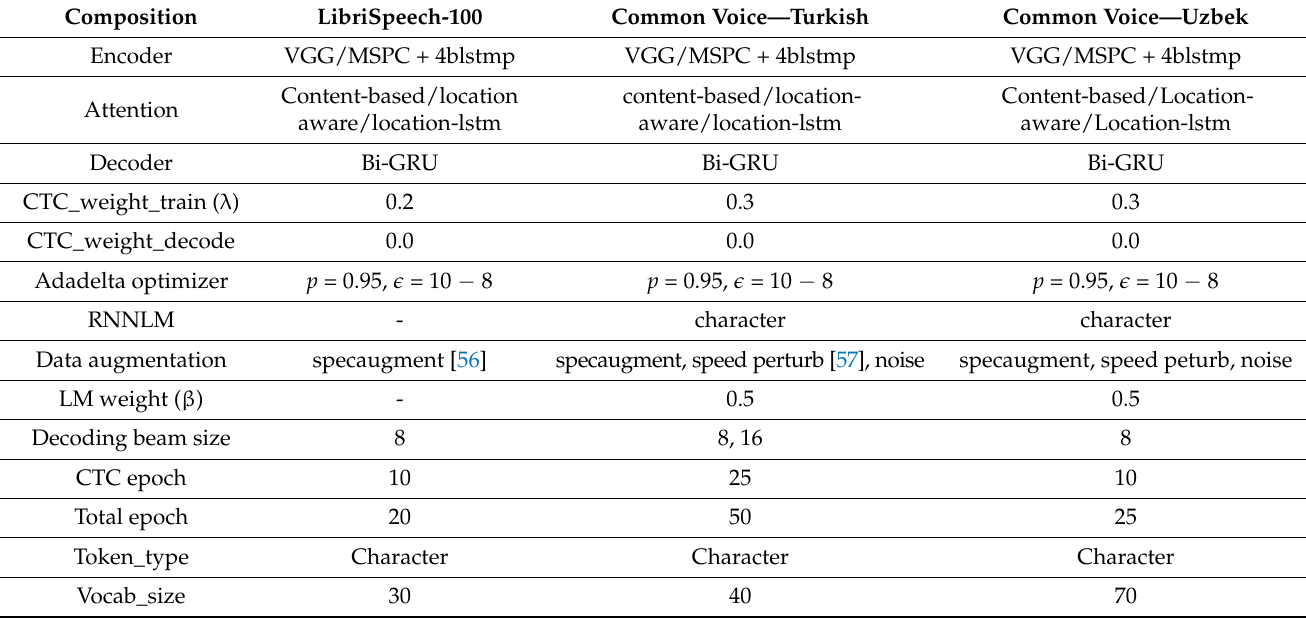
Table 2. Experimental